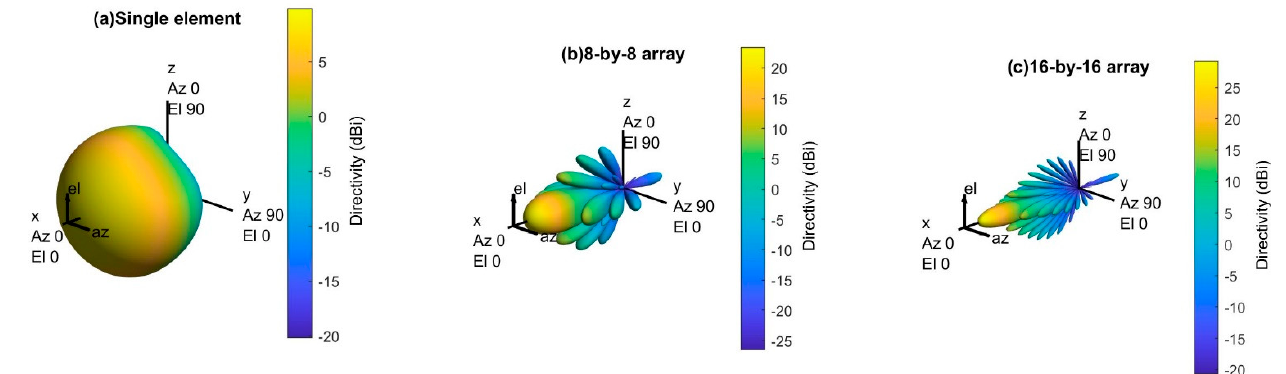
Figure 8. 3D radiation pattern of a single site with different array size .